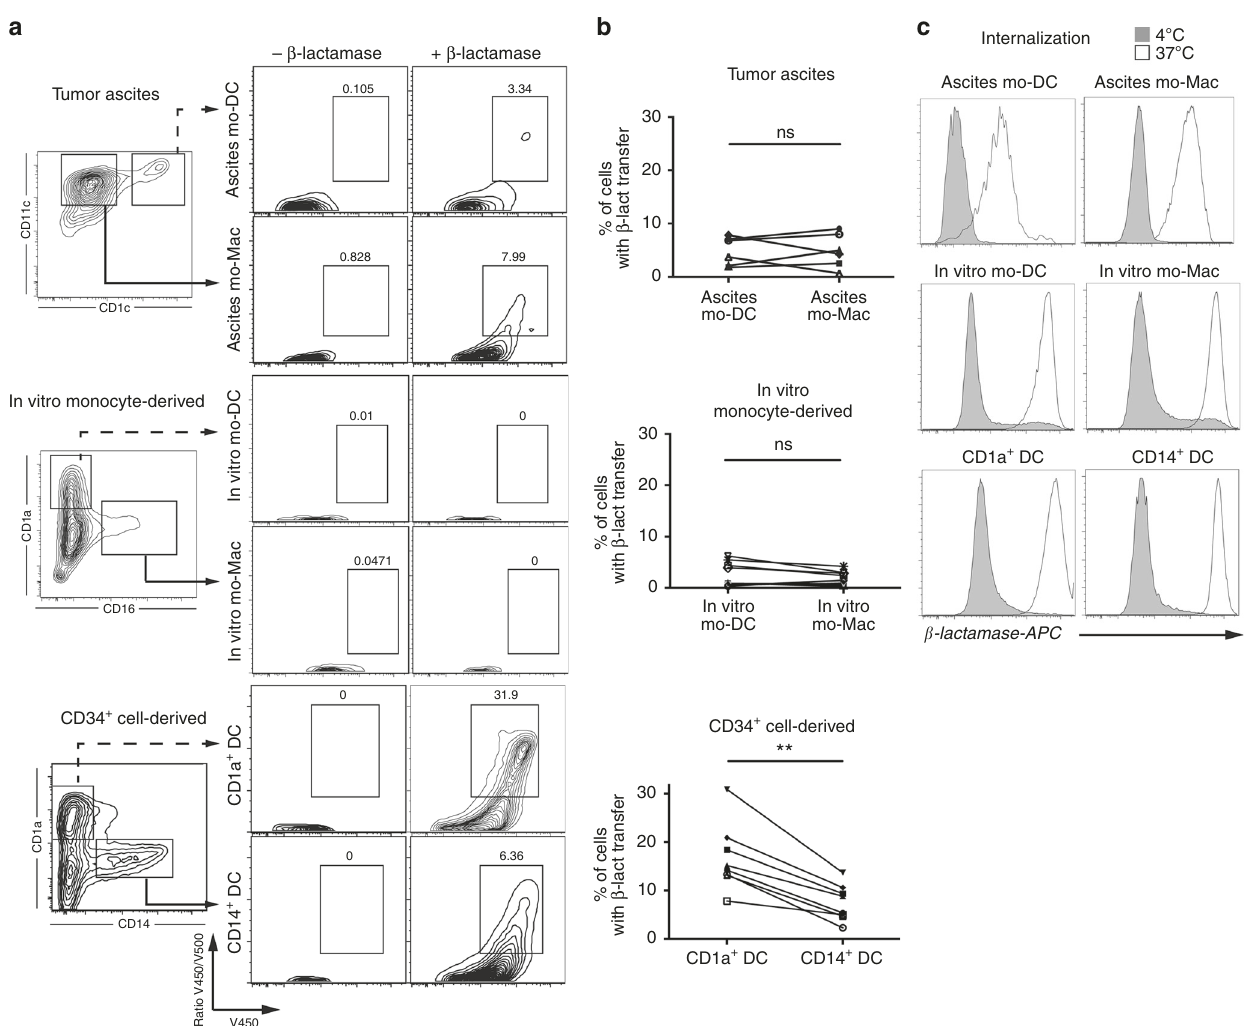
Fig. 4 Human mo-DCs and mo-Mac are inef fi cient for the transfer of exogenous proteins into their cytosol. a , b Puri fi ed DCs and macrophages from tumor ascites, derived in vitro from monocytes, or DCs derived in vitro from CD34 + precursors were loaded with a cell-permeable FRET-sensitive substrate of β -lactamase, and incubated with or without exogenous β -lactamase. After 3 h, cleavage was measured by fl ow cytometry. a Representative results of six (tumor ascites), ten (in vitro monocyte-derived), or eight (in vitro CD34 + cell-derived) independent experiments. b Quanti fi cation of β -lactamase transfer. Symbols represent individual donors. N = 6 for tumor ascites, N = 10 for in vitro monocyte-derived cells, and N = 8 for CD34 + cell-derived cells. ** p < 0.01, Wilcoxon non-parametric test. c Puri fi ed DCs or macrophages were incubated with β -lactamase coupled to Atto dye 633 at 4 or 37 °C during 3 h. Representative results of three independent